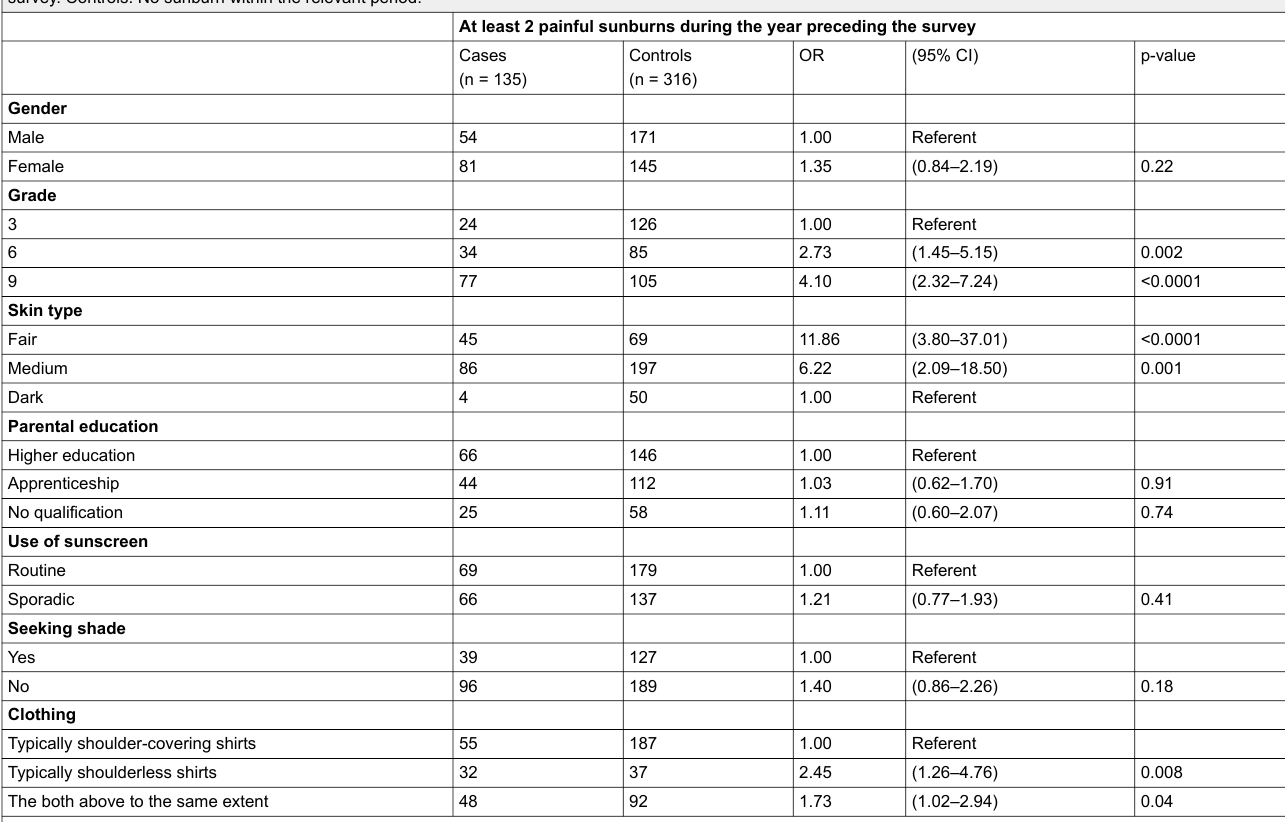
Table 4: Multivariate logistic regression analysis for the occurrence of at least 2 sunburns of medium severity (painful reddening of the skin) during the year preceding the survey. Controls: No sunburn within the relevant